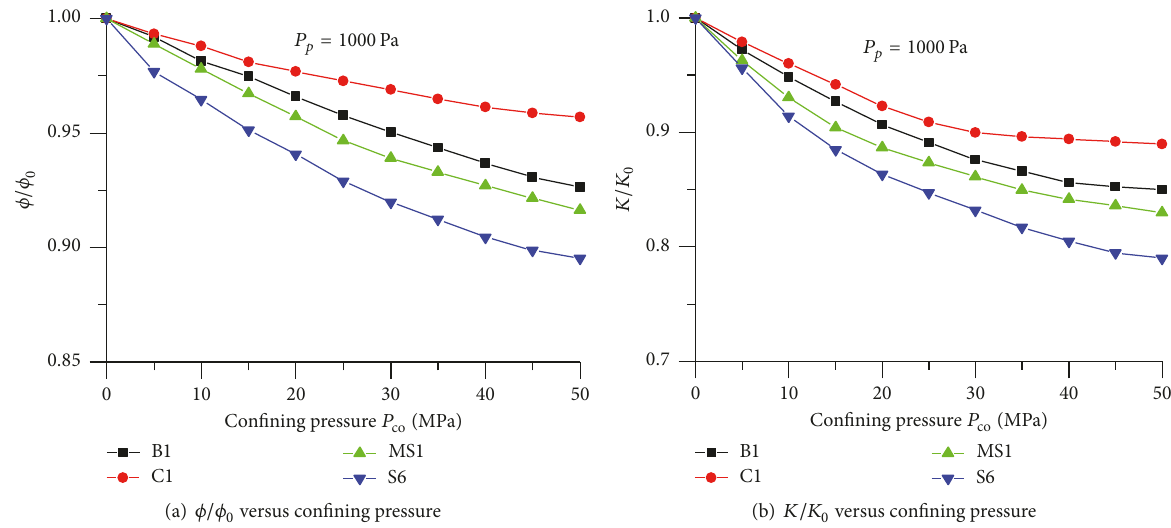
Figure 4: Variation of porosity and permeability with the rising of confining pressure and constant pore pressure. 𝜙/𝜙 0 refers to the ratio of the porosity under the simulation condition to the origin sample, so it is with 𝐾/𝐾 0 referring the permeability.